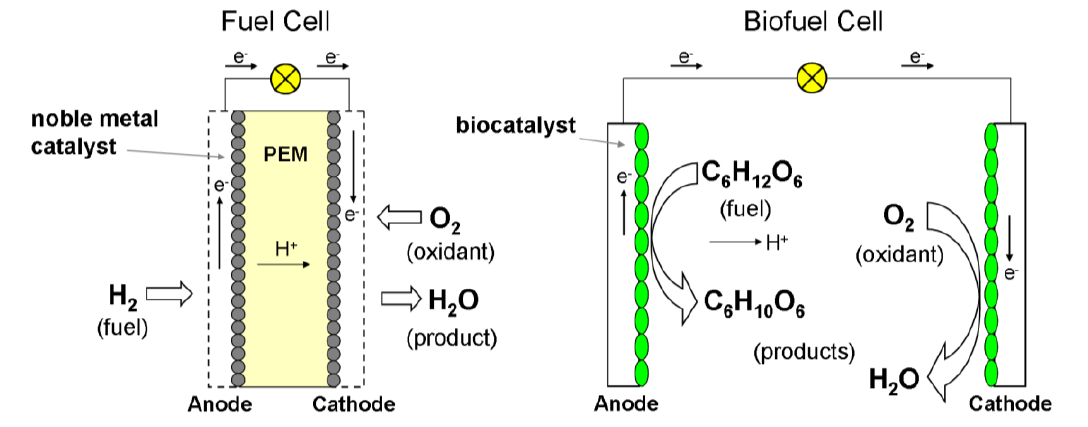
Figure 1. Schematic presentation of conventional PEM fuel cell and enzymatic biofuel